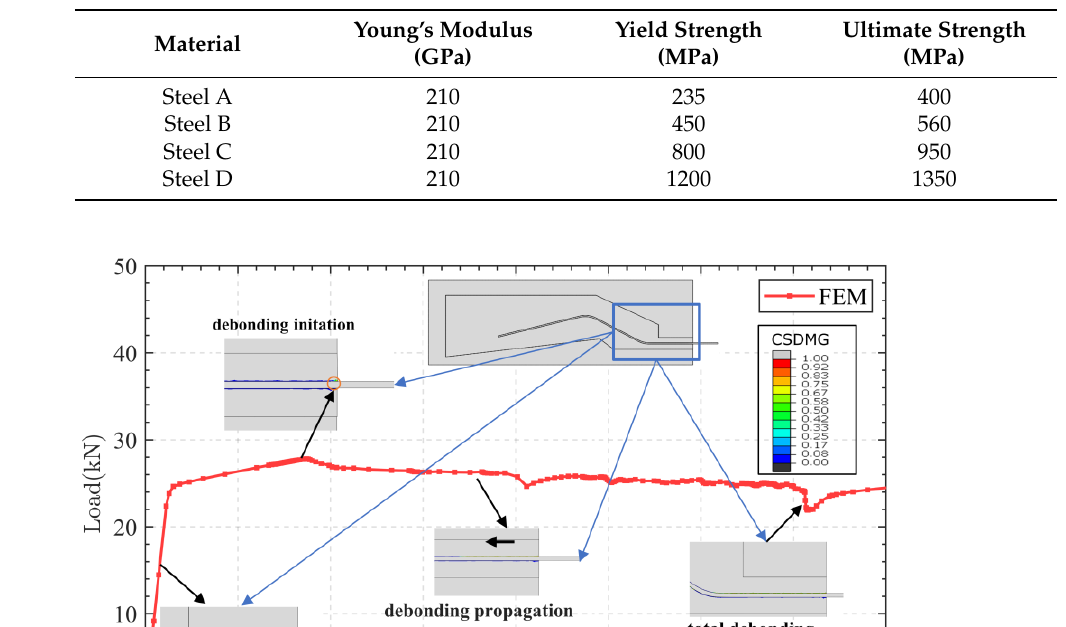
Table 2. Material properties of different steel material.